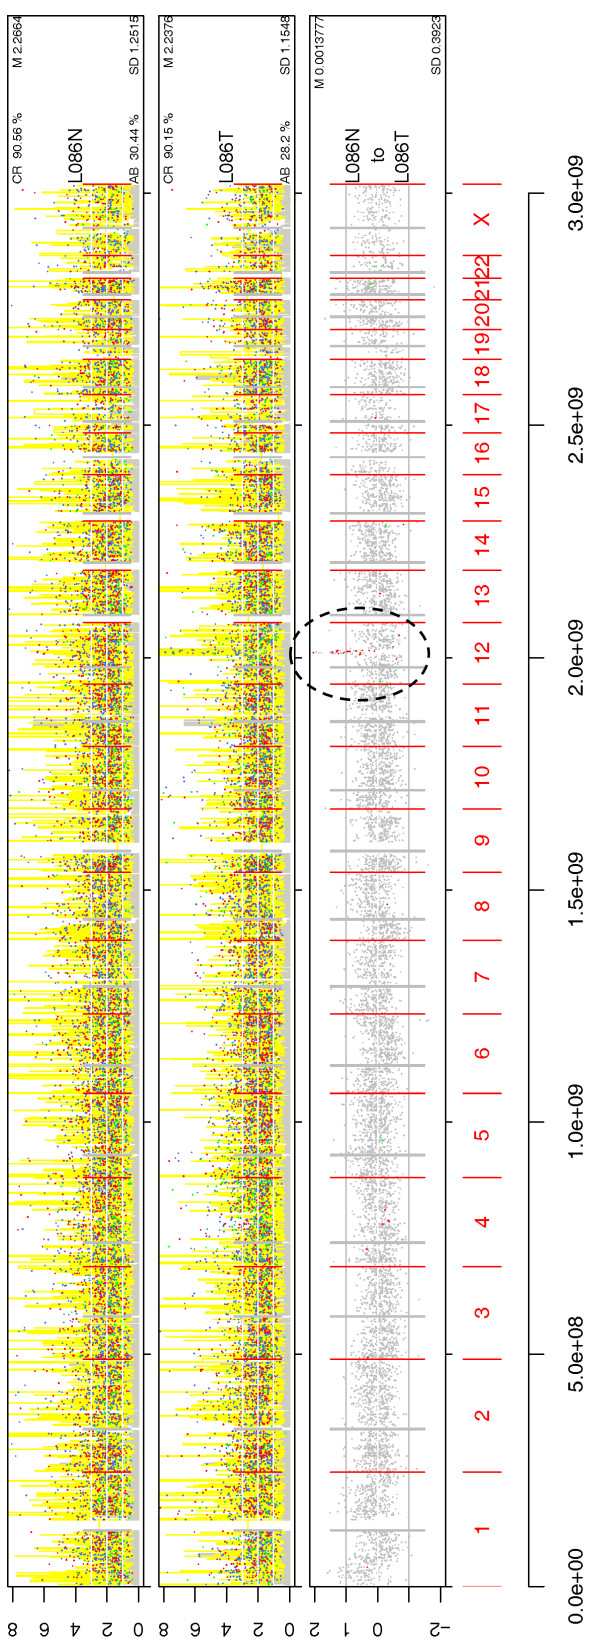
SNPscanPlot for paired data. When the paired data option is selected, SNPscan treats each two data sets as a pair, and produces a third track in the form of a ratio plot (in log2 scale) comparing the two samples. This feature is useful for any paired samples such as SNP profiles in normal versus cancer tissue. In this example the genotype changes from homozygous to heterozygous were indicated in red, while other optional color displays were suppressed. This highlighted a region of chromosomal amplification.